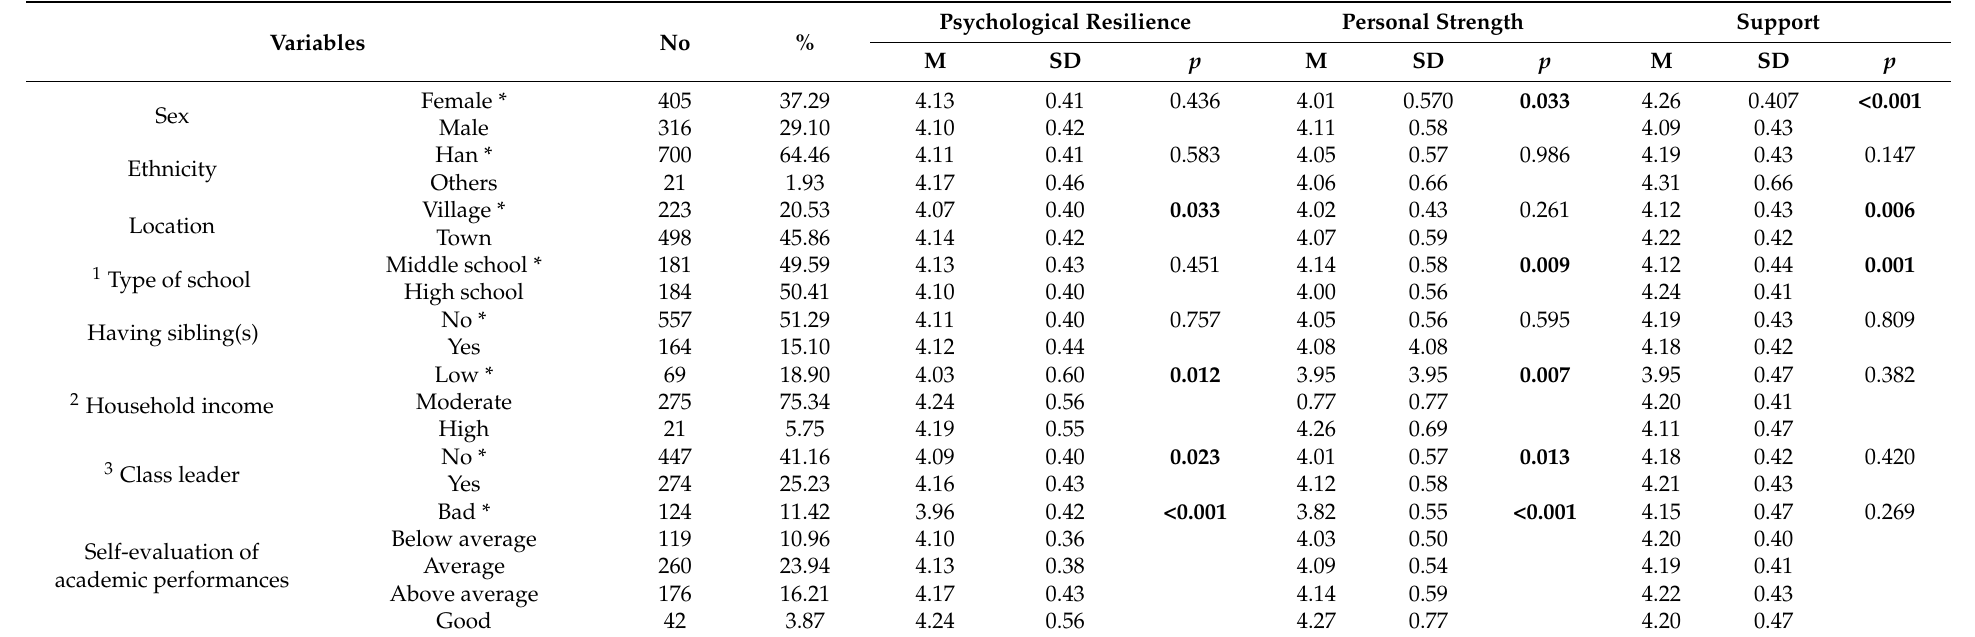
Table 6. Psychological resilience among non-left-behind